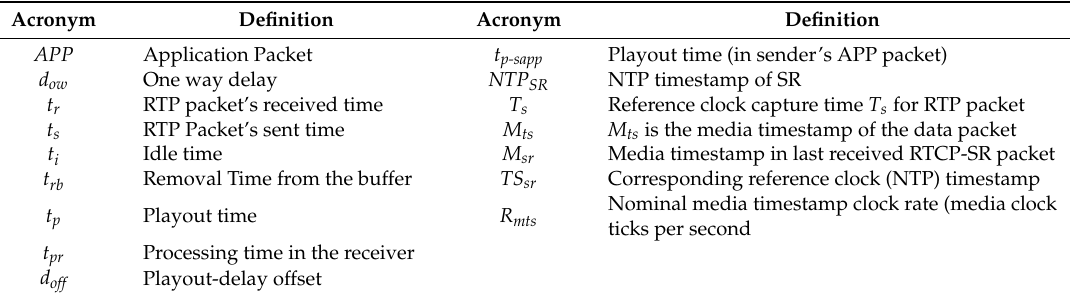
Table 1. Table of